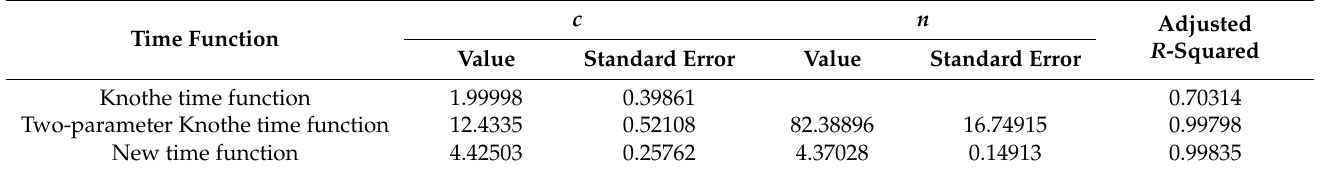
Figure 8. Qualitative comparison of fitting results for three kinds of time function. Table 2. Quantitative comparison of fitting results for three kinds of time function.